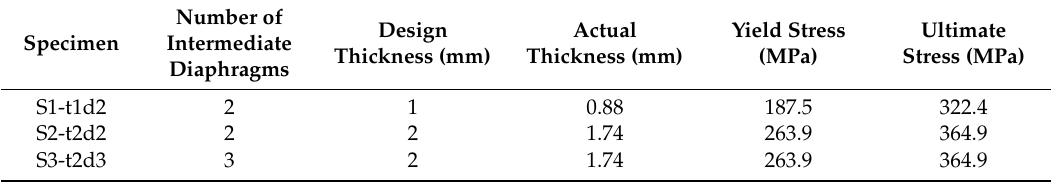
Table 11. Results of the material tests for the steel used for the